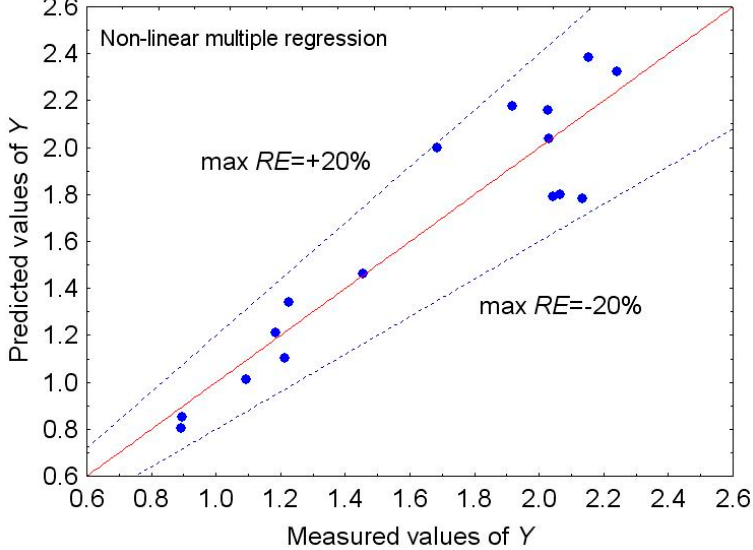
Figure 10. Comparison between measured values of the normalized undrained shear strength τ fu / σ ’ v and values predicted by the proposed relationship (Equation 22).